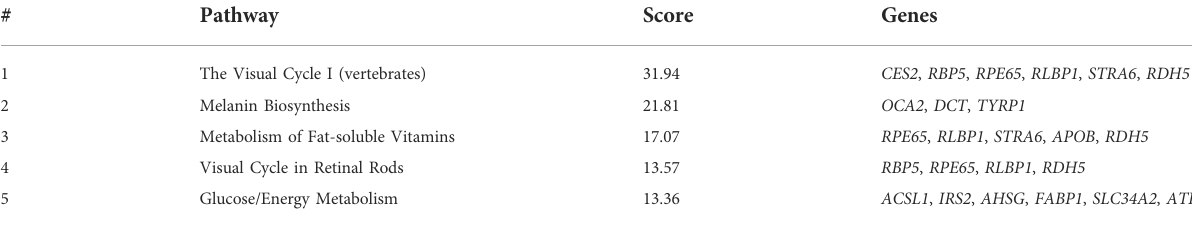
TABLE 3 Gene Analytics top enriched pathways in gne KO versus gne WT zebra fi sh at 5 dpf.